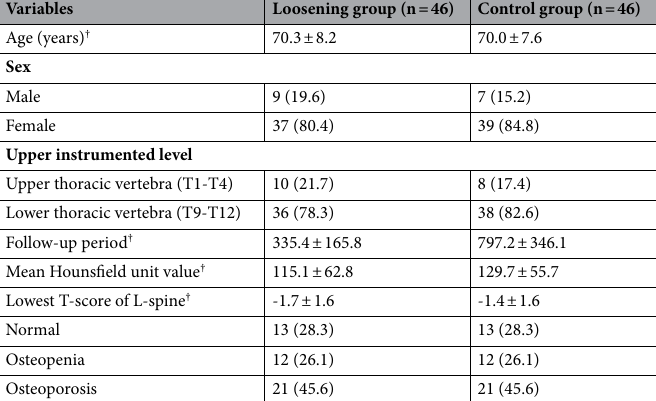
Table 1. Characteristics of the loosening and control groups. Unless otherwise indicated, data are presented as numbers of patients (%). † Data are presented as mean ± standard deviation.